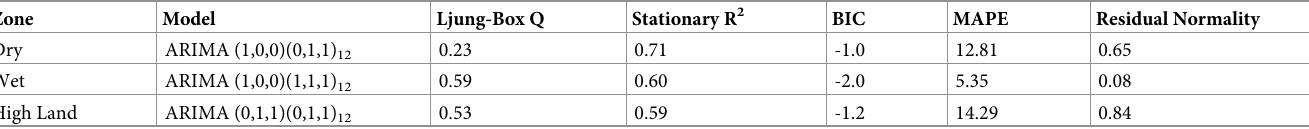
Table 6. Best-fitting univariate SARIMA models to describe the incidence of leptospirosis in three climate zones in Sri